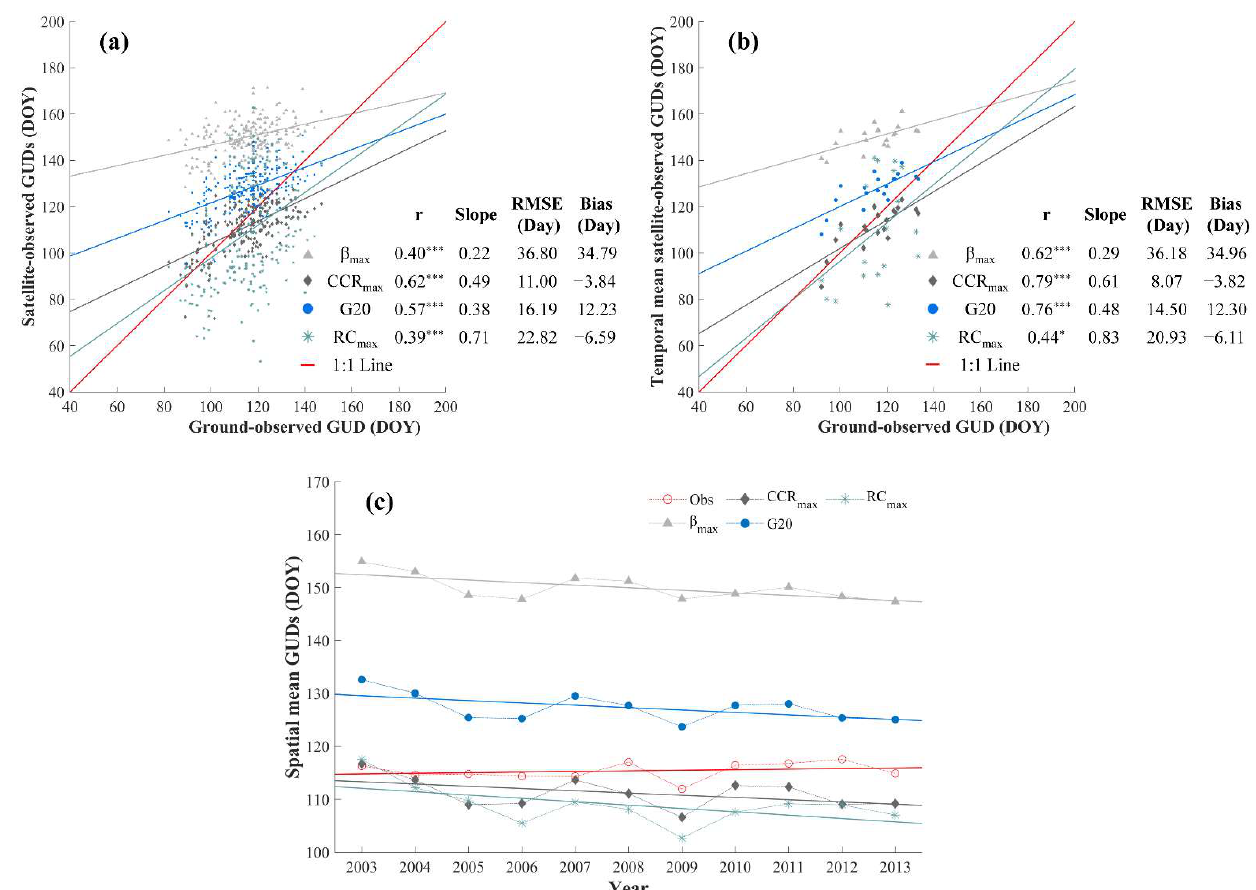
Figure 5. Performance comparison of GUD derived from NDGI through four methods (β max , CCR max , G20, RC max ). ( a ) Scatterplots and linear regression models of ground-observed GUD and satellite- observed GUDs extracted by the four methods for all site-years; ( b ) Scatterplots and linear regression models of the temporal-averaged GUDs for all sites. The symbols * and *** are significant at levels of 0.1 and 0.01, respectively. ( c ) Inter-annual variations and trends of spatial-averaged GUDs for all years. DOY, day of the year.